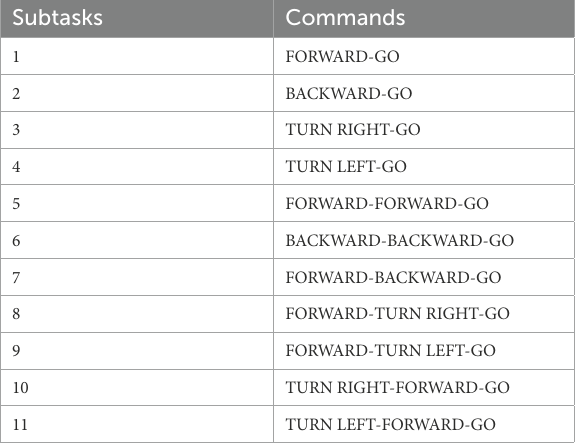
TABLE 4 Short sequences of commands.